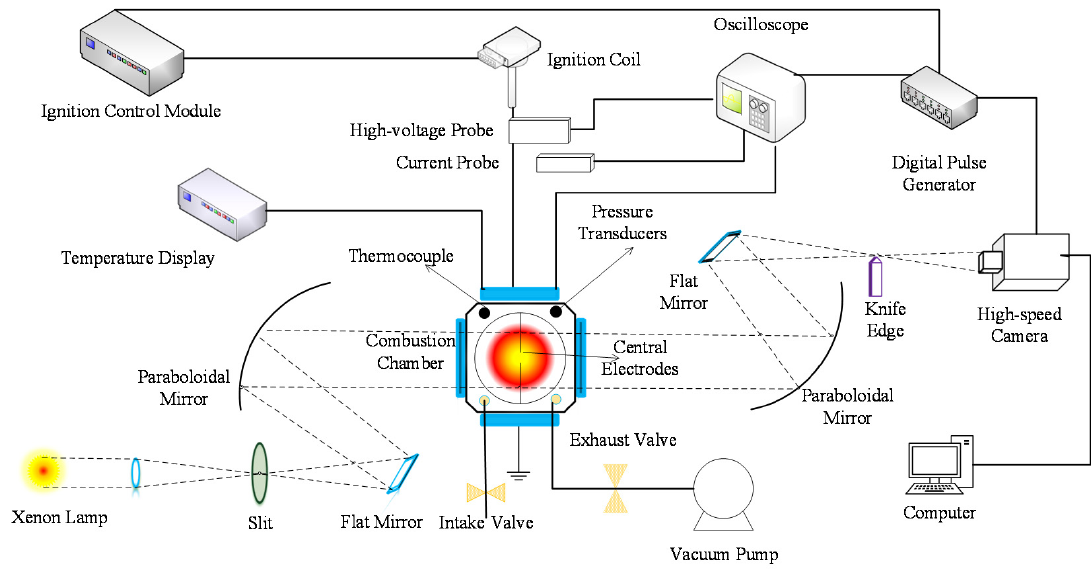
Figure 1. Schematic of the experimental setup.